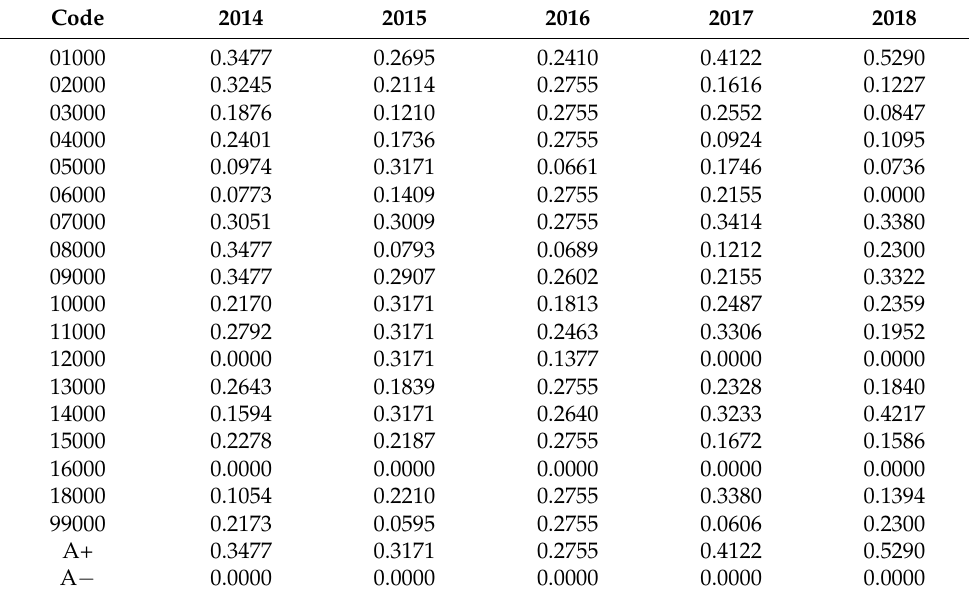
Table A9. The second step of TOPSIS analysis is adopted for the deficiency data of Taiwanese ship.